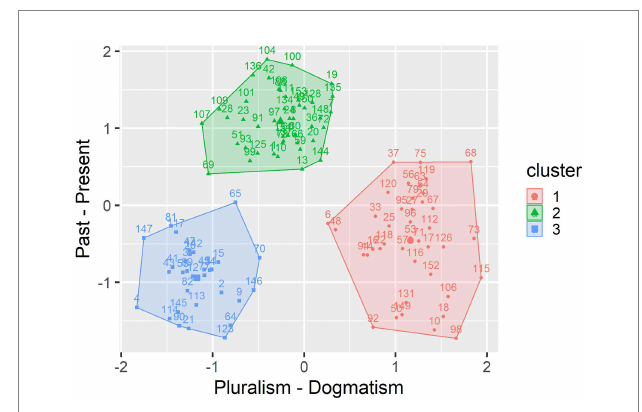
FIGURE 2 Idealized cluster solution obtained from linear discriminant